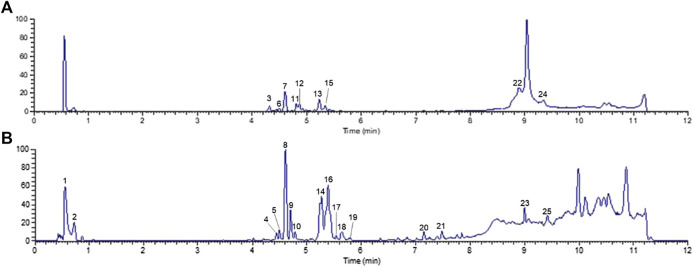
Total ion chromatogram monitored in positive (A) and negative (B) ion modes for ginseng.